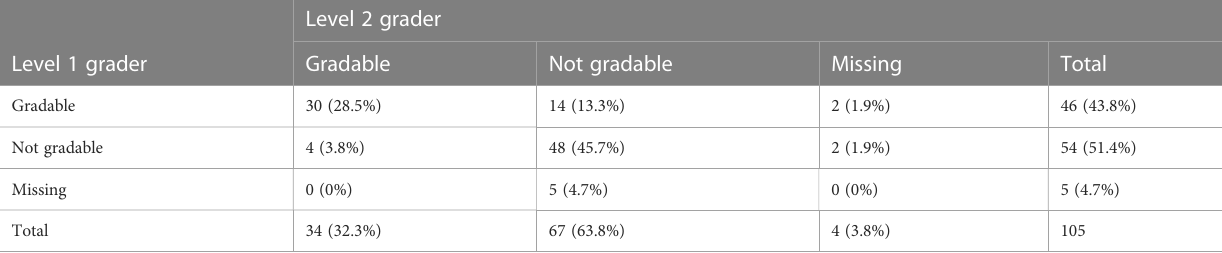
TABLE 5 The grading of the ungradable images of grader 3 by graders 1 and 2.